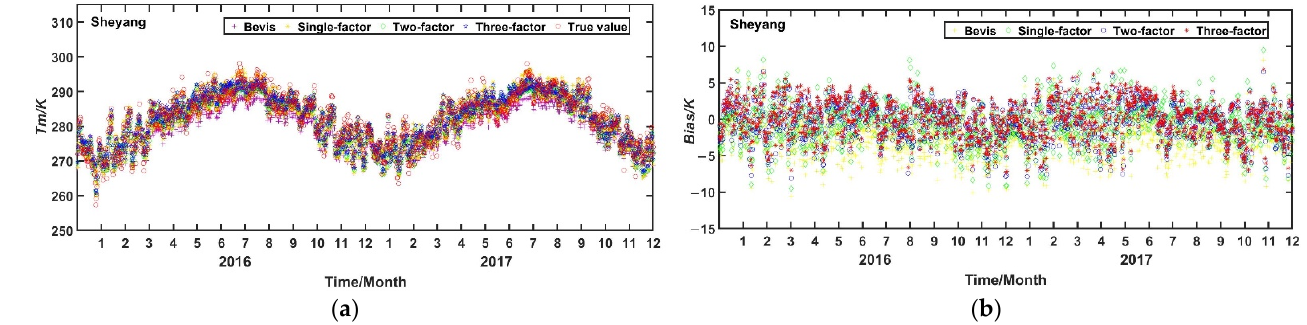
Figure 5. Time series of T m ( a ) and the biases ( b ) of Bevis, one-factor, two-factor and three-factor RTMs to the radiosonde-derived T m at Sheyang station during 2016–2017.